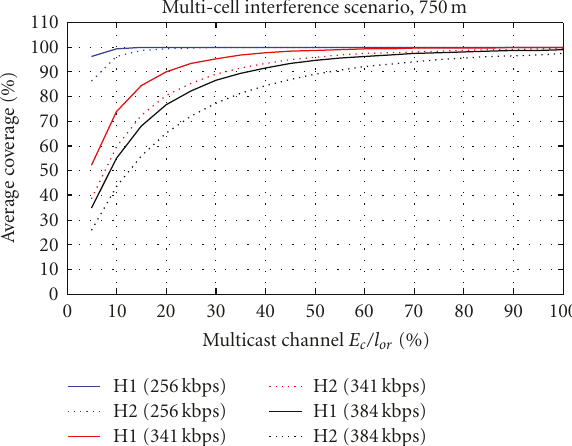
Figure 13: Throughput versus distance between UEs and BS, k = 0 . 5.